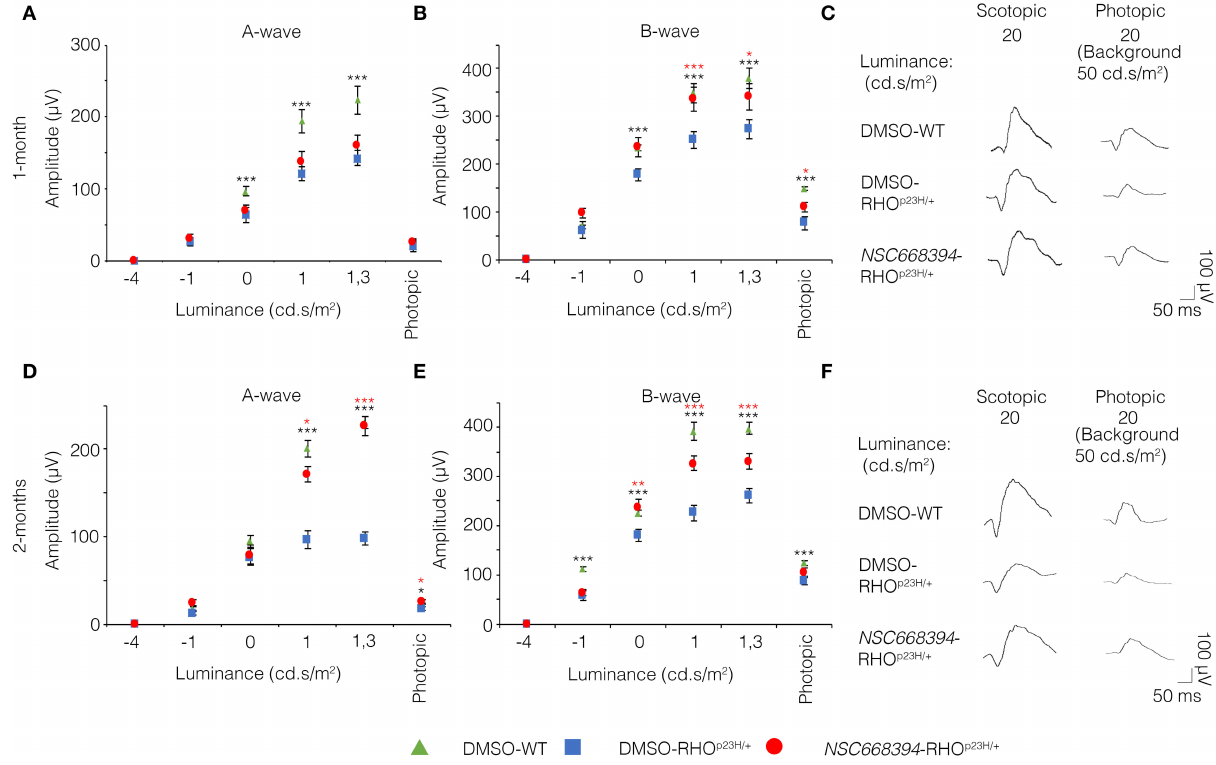
FIGURE 1 | NSC668394 RHO P23H / + mice treatment results in progressive functional rescue of photoreceptors deficiency. (A,B) Representative ERG ( a - and b -wave), plotted as a function of stimulus intensity, from 1-month old DMSO-treated WT (green triangle), DMSO-treated RHO P23H / + (blue square), and NSC668394 -treated RHO P23H / + (red circle) mice. Error bars represent SEM. *** p ≤ 0.005, * p ≤ 0.05 t -test (DMSO-RHO P23H / + vs. DMSO-WT; NSC668394 -RHO P23H / + vs. DMSO-RHO P23H / + ). (C) Representative ERG (scotopic and photopic responses) traces of DMSO-treated WT, DMSO-treated RHO P23H / + , and NSC668394 -treated RHO P23H / + mice at 1-month of age. Scotopic indicates ashes of 20.0 cd · s/m 2 light intensity; photopic indicates ashes of 20.0 cd · s/m 2 light intensity on a